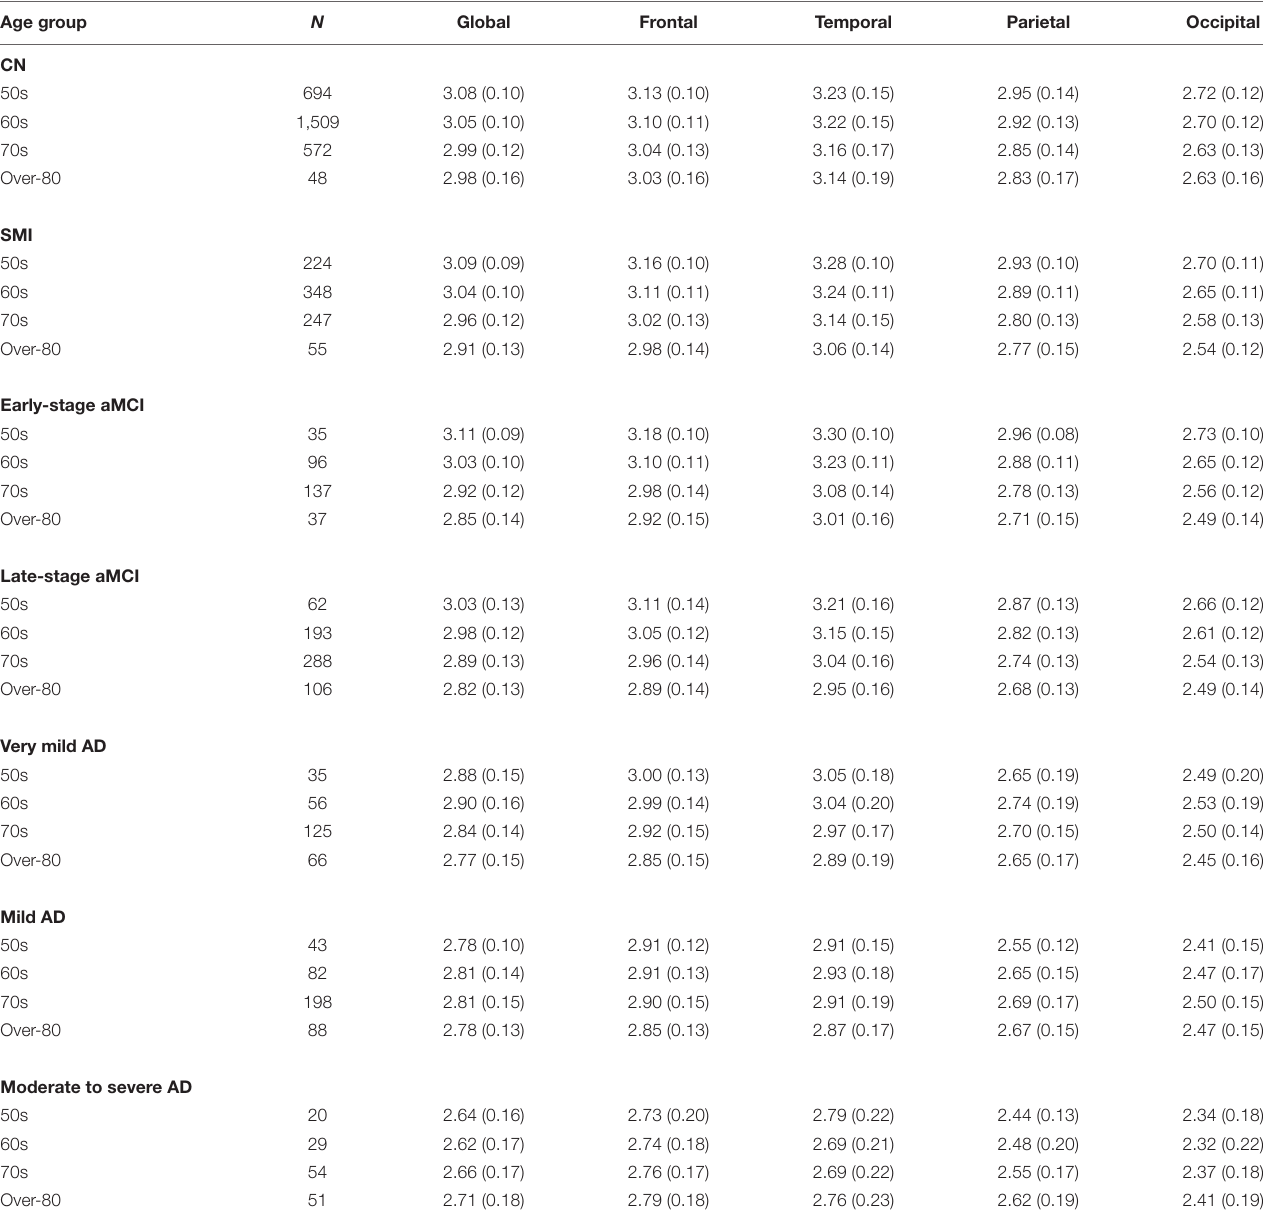
TABLE 2 | Mean and SD of the cortical thickness for each age group according to the diagnostic groups. Age